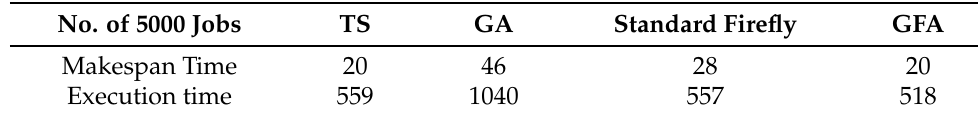
Table 8. Makespan and Execution times for Lightweight Workloads.